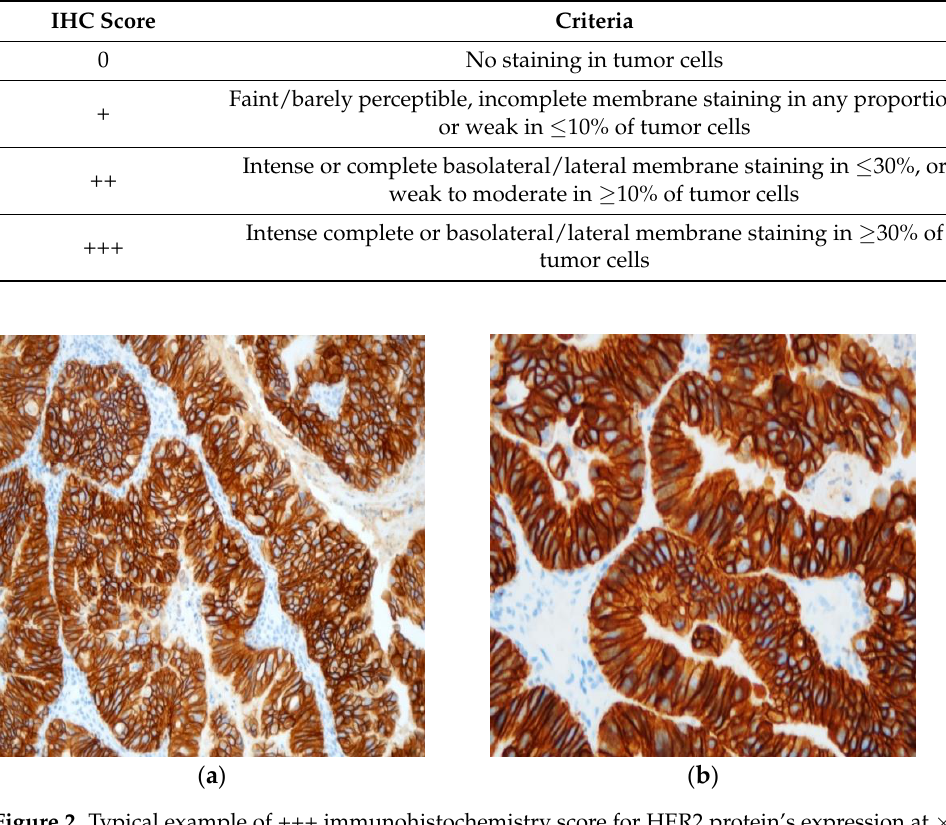
Figure 2. Typical example of +++ immunohistochemistry score for HER2 protein’s expression at ×20 ( a ) and ×40 ( b ) power fields.